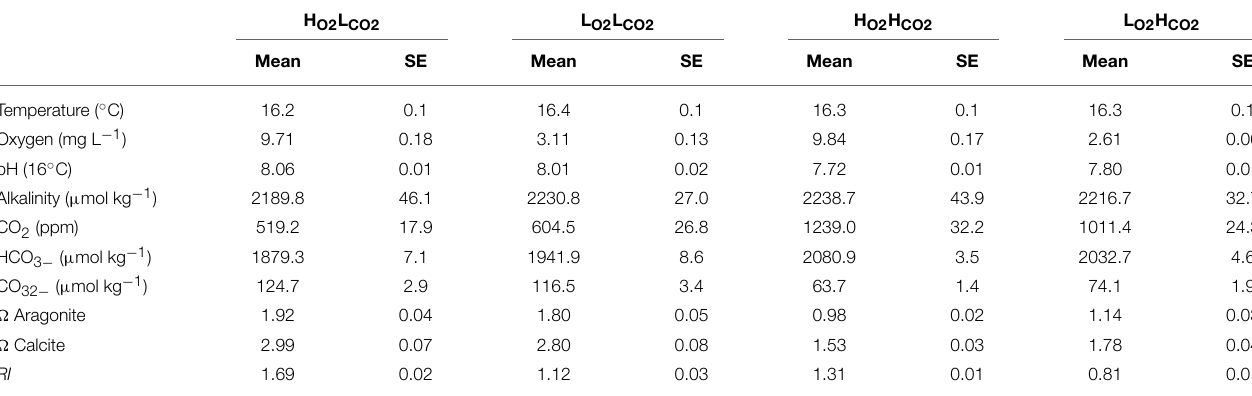
TABLE 1 | Mean ( ± SE) of the seawater parameters in the aquaria per